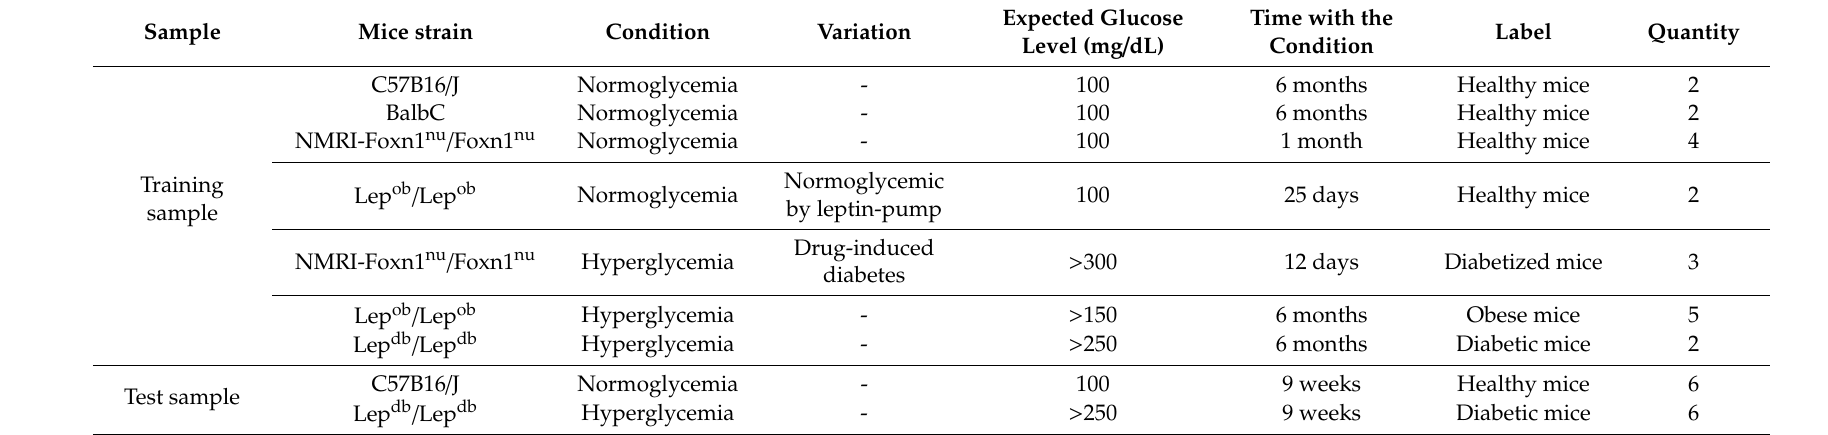
Table 1. Mice strains employed for the validation